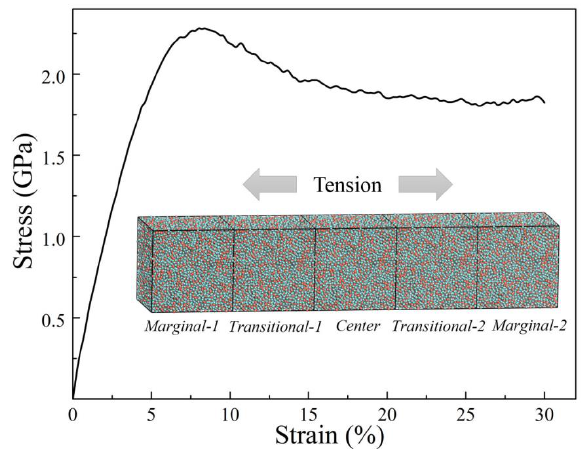
Figure 2. The MD simulated uniaxial stress-strain curve of the Zr 2 Cu structural model under tension. The inset is the enlarged model which was obtained by reproducing the MD and RMC simulated cubic model along the X-direction five times. This enlarged model was divided into three kinds of regions named center, transitional 1 , 2, and marginal 1, 2.